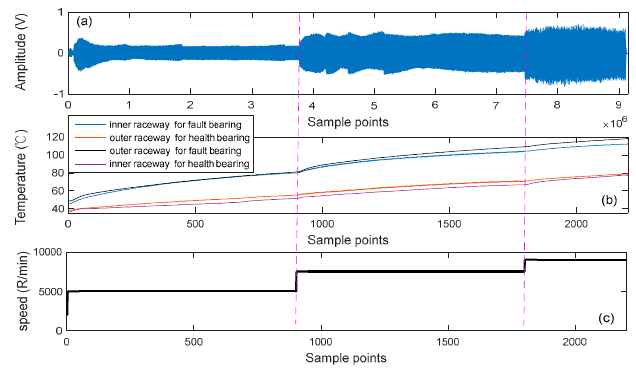
Figure 30. Monitored data of different test conditions. ( a ) vibration signal, ( b ) temperature signal, and ( c ) rotational speed.